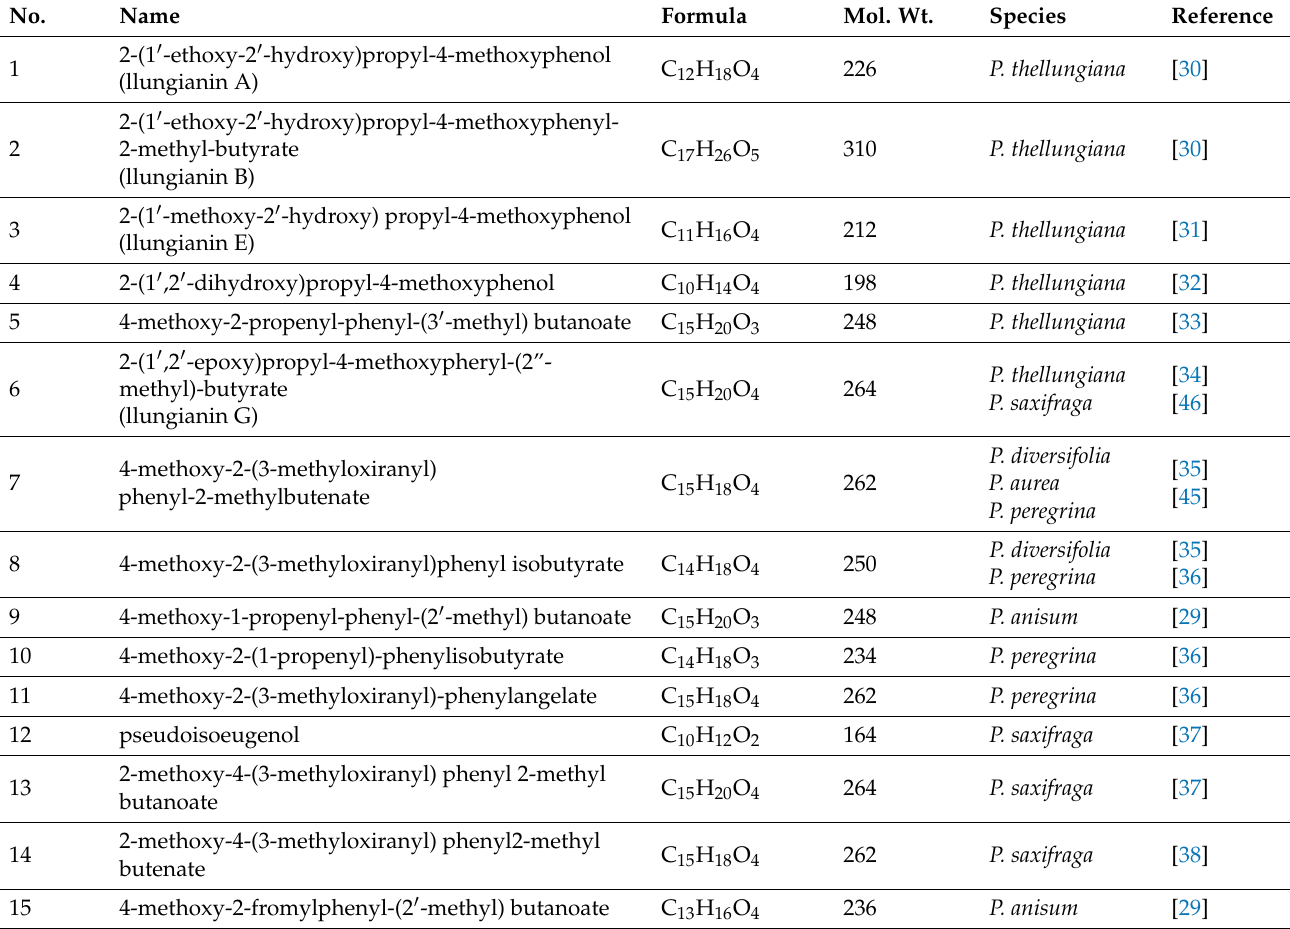
Table 2. Phenylpropanoids of Pimpinella